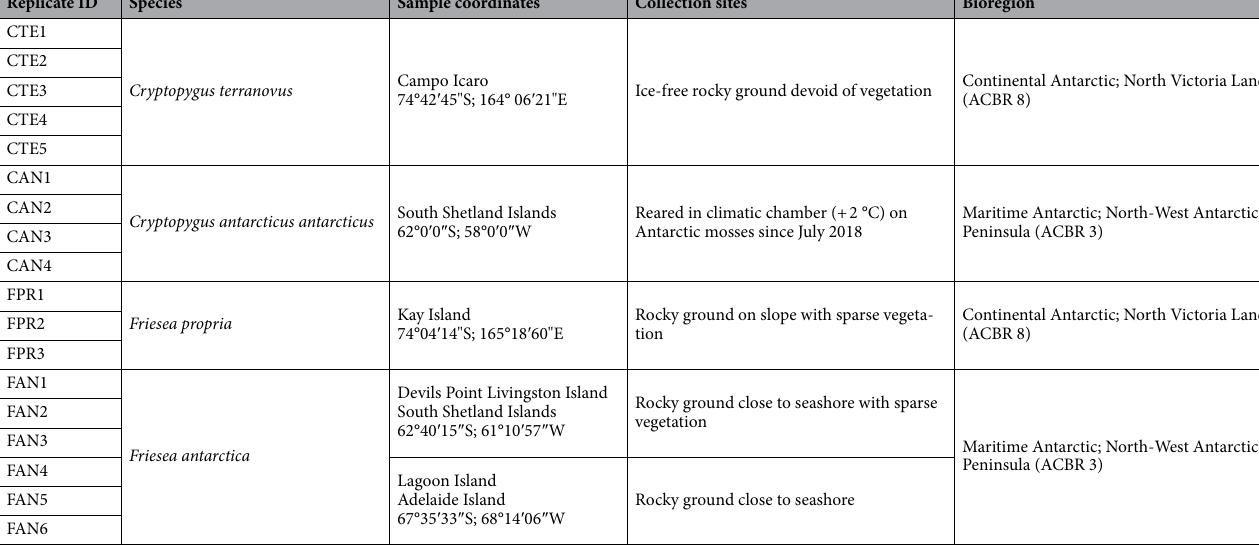
Table 1. List of the species included in the present study. The number of replicates per species, as well as the collection site, the geographical coordinates and the bioregion are